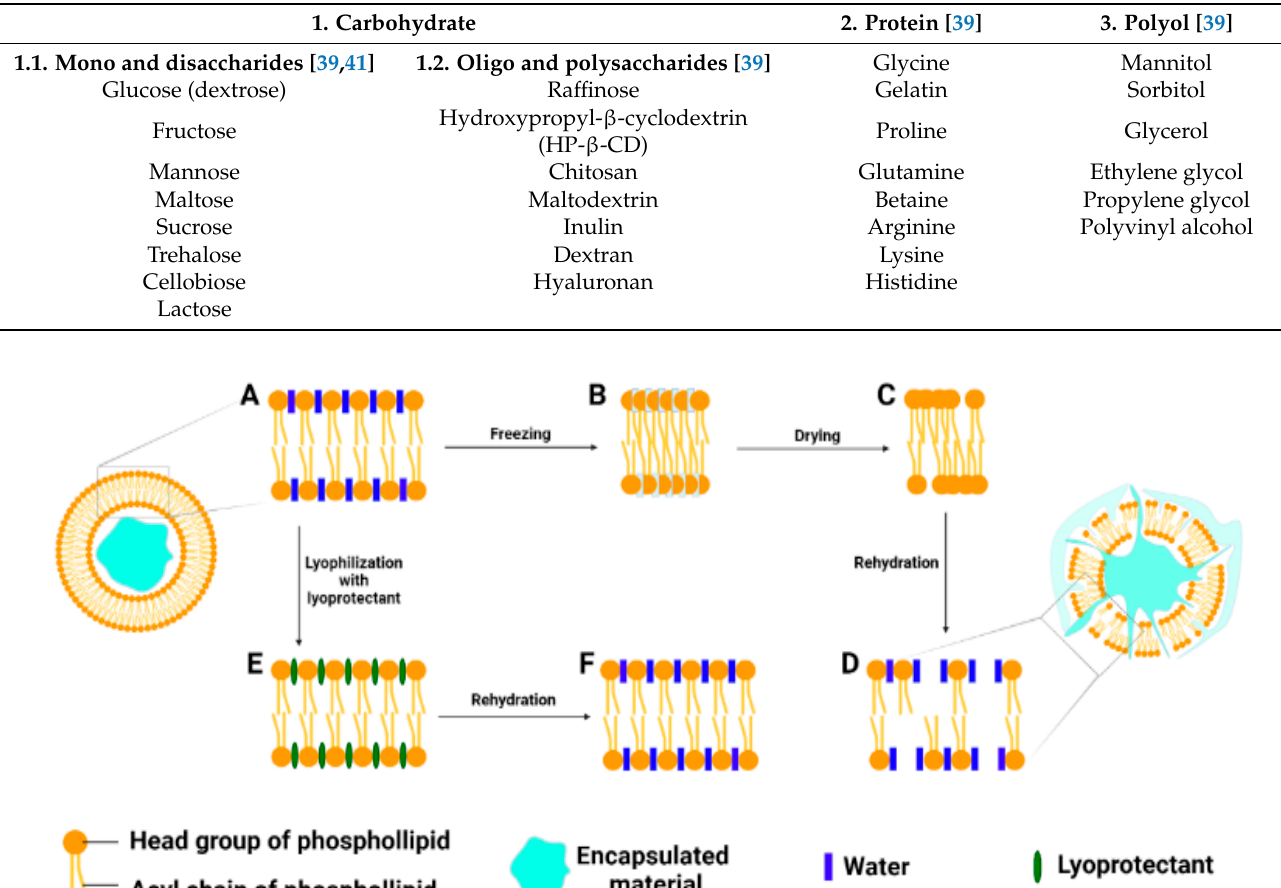
Table 2. Classification of lyoprotectants.